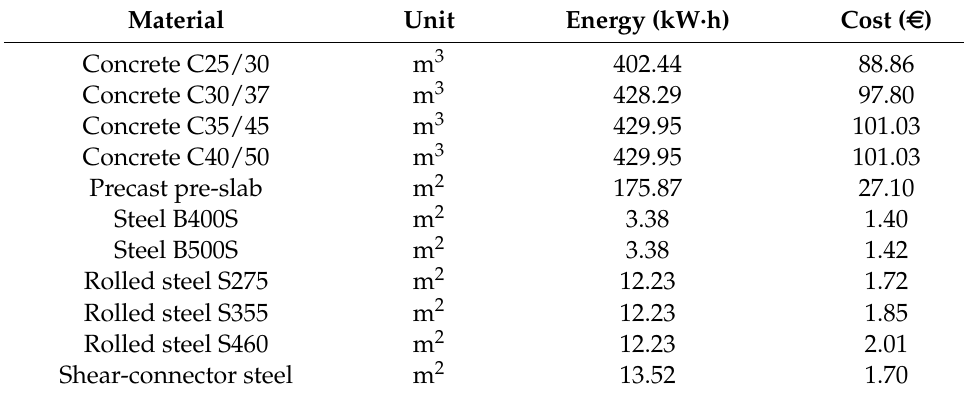
Table 1. Embodied energy and cost values for